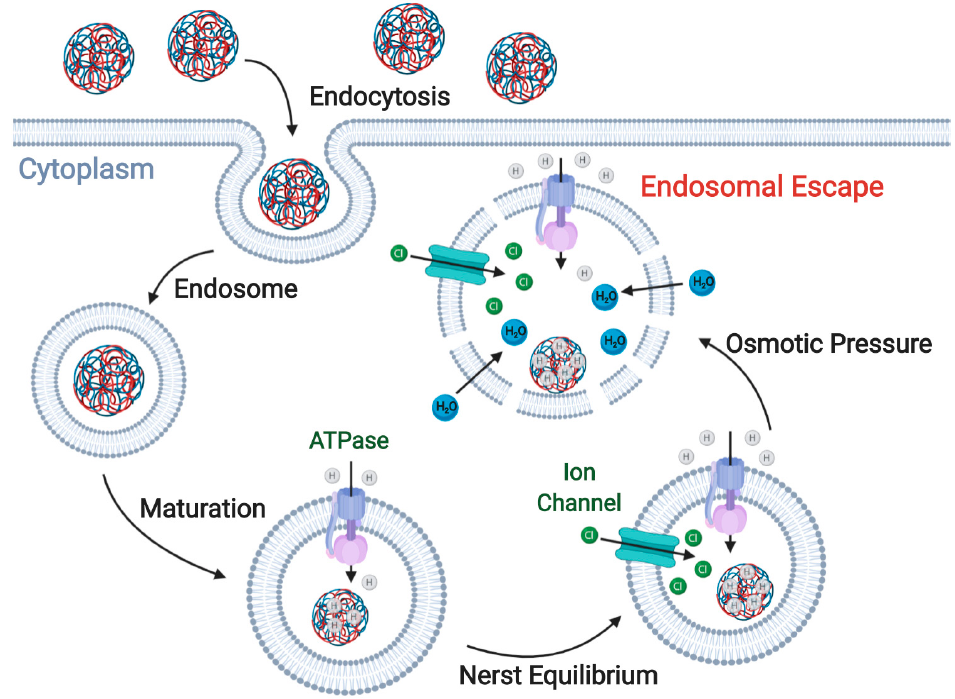
Figure 4. Endosomal escape mediated by the Proton-Sponge Effect. Surface coatings of IONs sequester protons from the endosomal lumen and create an osmotic gradient. The increase in osmotic pressure, coupled with destabilizing interactions between cationic surfaces of IONs and the endosomal membrane ultimately leads to the lysis of endosomal vesicles. (Created with BioRender.com).